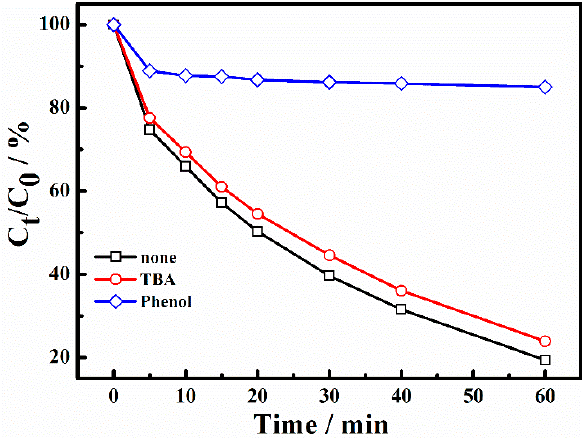
Figure10. Thee ff ectofradicalscavengersonthedegradationofX-3B.([TBA] 0 = 20M,[Phenol] 0 = 20 Figure 10. The effect of radical scavengers on the degradation of X-3B. ([TBA] 0 = 20 M, [Phenol] 0 = 20 M).